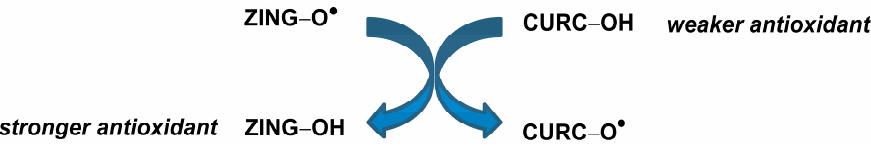
Figure 11. Interaction between two antioxidants .